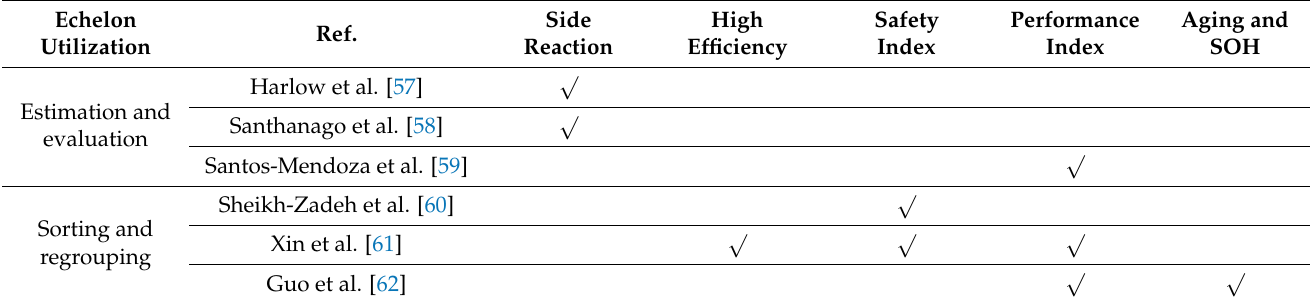
Table 6. Related research points for echelon utilization for EV